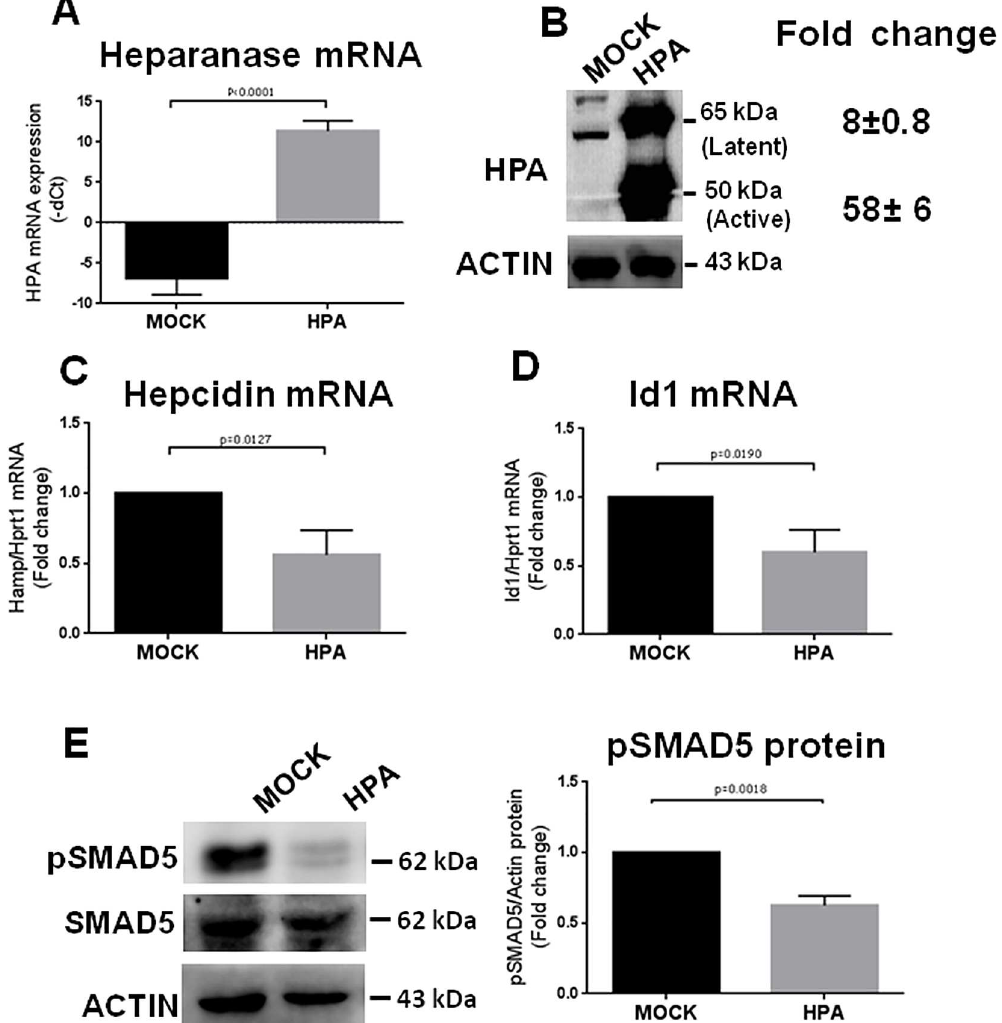
Fig 1. HepG2 cells transiently transfectedwith heparanase showed a reduction of hepcidin mRNA. HepG2 cells were transfected with pcDNA3.1-HPA plasmid (HPA) or empty pcDNA3.1 as control (MOCK) and harvested 48 h after the transfection. (A) Relativelevel of HPA mRNA was measured by qRT-PCR (B) Western blot of SDS-PAGE with anti-HPA antibodiesshow the levels of its latent (65 kDa) and active (50 kDa) form. Densitometry quantification of the two protein forms was performed in relationto Actin. (C) The level of hepcidin mRNA and (D) Id1 mRNA was analyzedby qPCR and normalized for Hprt1. (E) The phosphorylated (pSMAD5) and total SMAD5 were analyzedby western blot and pSMAD5 densitometry was normalizedto actin. In (A) the values are expressedas–dCt for HPA mRNA, in C and D as fold change over the control (MOCK) for hepcidinand Id1 mRNA.,